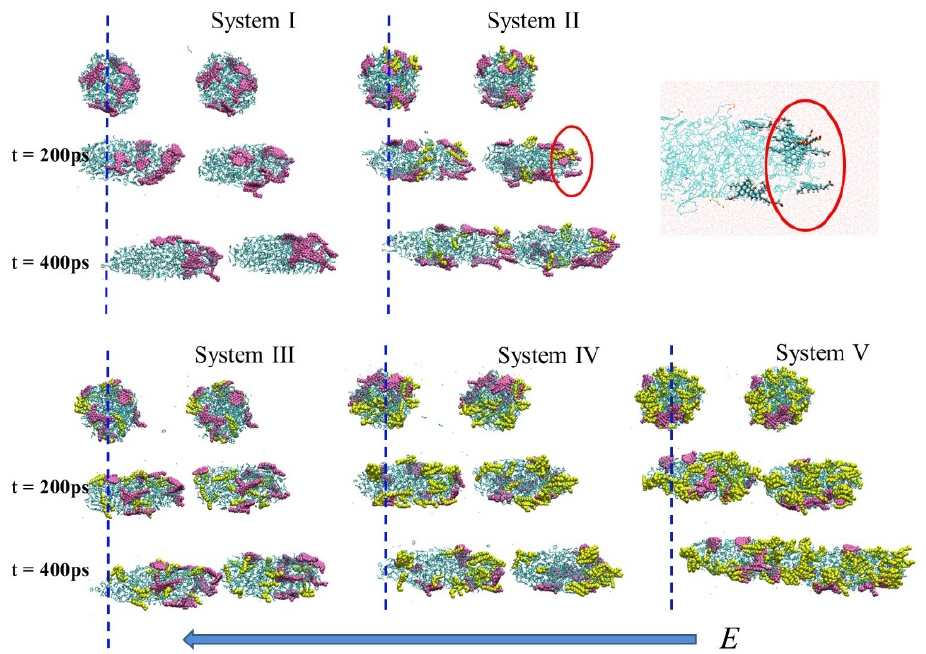
Figure 2. The behavior of oil droplets under BPEF output duration. Asphaltene molecules were colored pink. SDS molecules were colored yellow. Resins and light crude oil molecules were colored green.